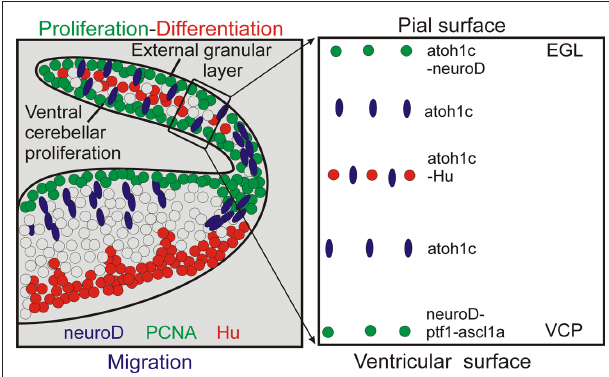
Figure 5 | Schema summarizes neurogenesis in zebrafish cerebellar plate. Left panel: Interpretative sketch based on localization of cellular marker in zebrafish cebellar plate as shown in Figure 4 . GABA as shown in Mueller and Wullimann (2006). Right panel: summary of markers at various dorsoventral levels of zebrafish cerebellar plate. Data as shown in left panel and compiled from Kani et al., 2010 ( ptf1